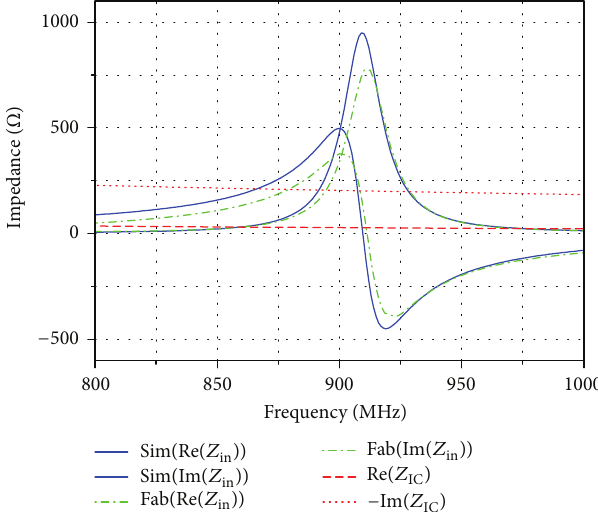
Figure 12: Simulated (blue) and measured (green) antenna’s input impedance and IC’s impedance (red).